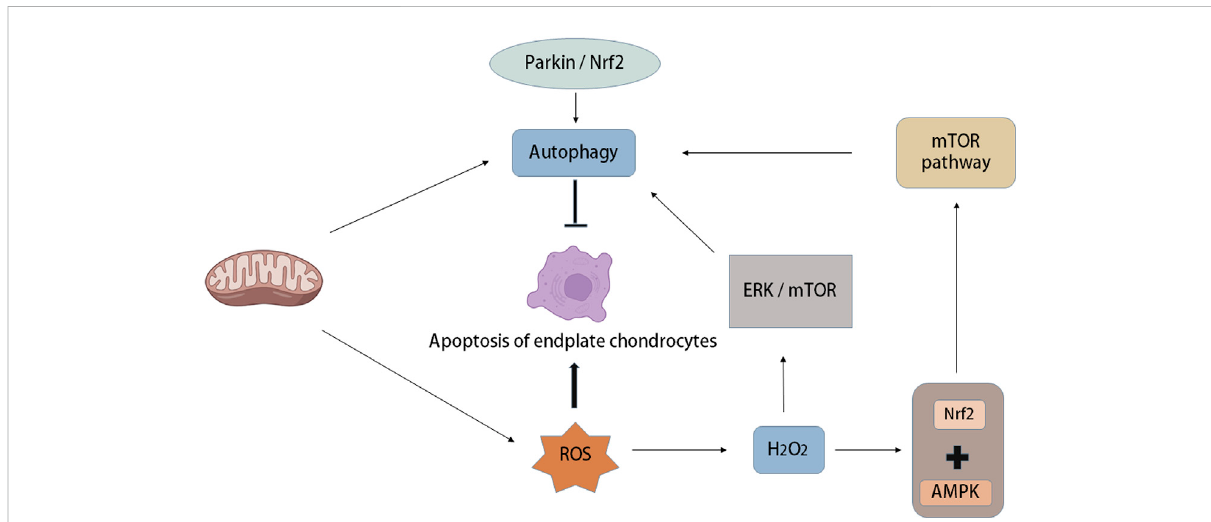
FIGURE 5 Autophagy and oxidative stress in intervertebral disc degeneration. Mitochondria are not only the place where ROS is produced, but also the organelles that regulate autophagy. Oxidative stress can increase autophagy and apoptosis of intervertebral disc endplate chondrocytes, while the increase ofautophagy activity can prevent endplate chondrocyte apoptosis,in which oxidative stress-induced autophagy ofendplate chondrocytes is mTOR-dependent. A large amount of ROS was produced after mitochondrial injury, in which the increase of H 2 O 2 concentration led to the activation of 5 ′ -adenosine monophosphate-activated protein kinase (AMPK), while the combination of Nuclear factor (erythroid-derived-2)-like 2 (Nrf2) and AMPK induced autophagy through the down-regulation mechanism of mTOR. In addition, Parkin and Nrf2 can prevent apoptosis of intervertebral endplate chondrocytes induced by oxidative stress by inducing mitochondrial